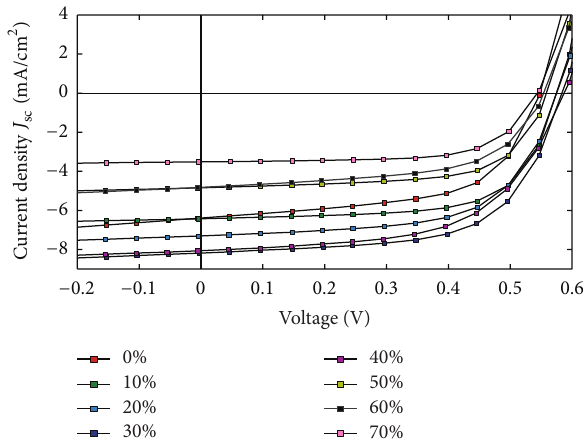
Figure 1: 𝐽 - 𝑉 characteristics of organic solar cells with the active layer containing a glycerol additive of varying